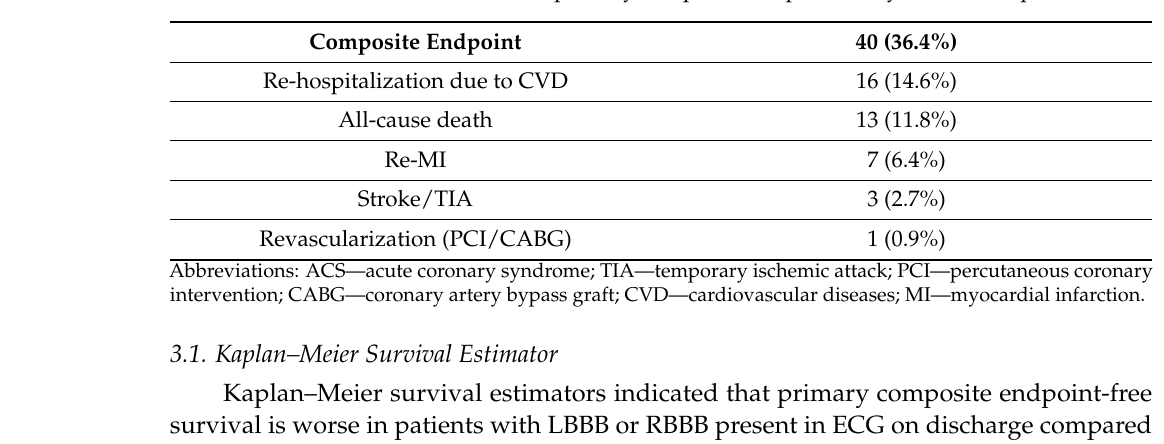
Table 3. Occurrence of elements of the primary composite endpoint at 3-year follow-up.